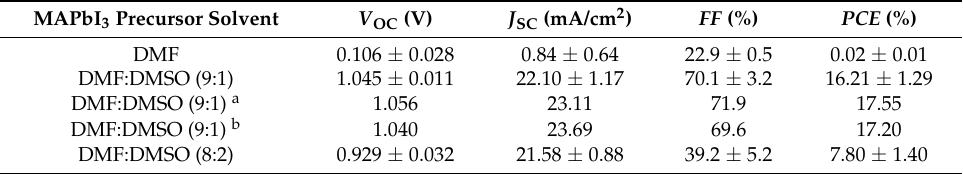
Figure 1. ( a ) J - V curves of MAPbI 3 -based photovoltaics under one sun illumination under forward scanning direction; ( b ) J - V curves of the best MAPbI 3 -based photovoltaics under one sun illumination under forward and backward scanning directions. Table 1. Photovoltaic performance under one sun illumination (AM 1.5G, 100 mW/cm 2 ). MAPbI 3 Precursor Solvent